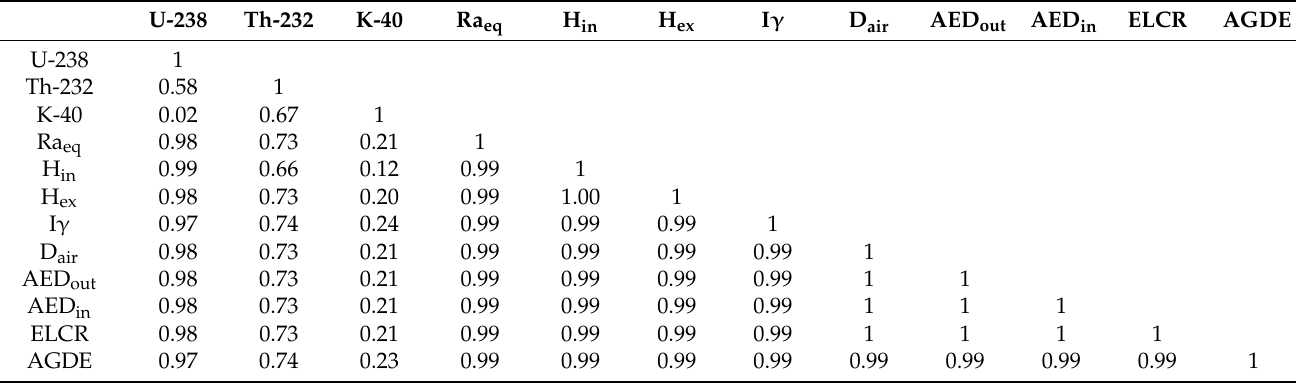
Table 4. Pearson correlation between natural radionuclides and the radiological hazard coefficients of muscovite granite rocks, Gabal Qash Amir,